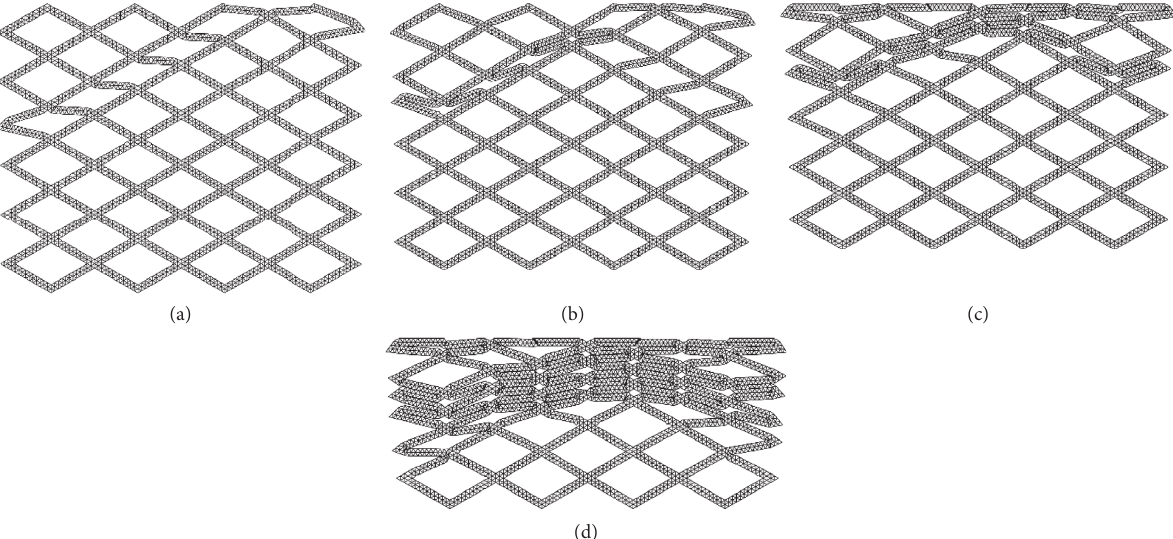
Figure 5: FE prediction of quasi-static collapse of the DHH in the x direction, N � 12 and ρ � 5%. (a) ε � 6%. (b) ε � 12%. (c) ε � 24%. (d) ε � 48%.